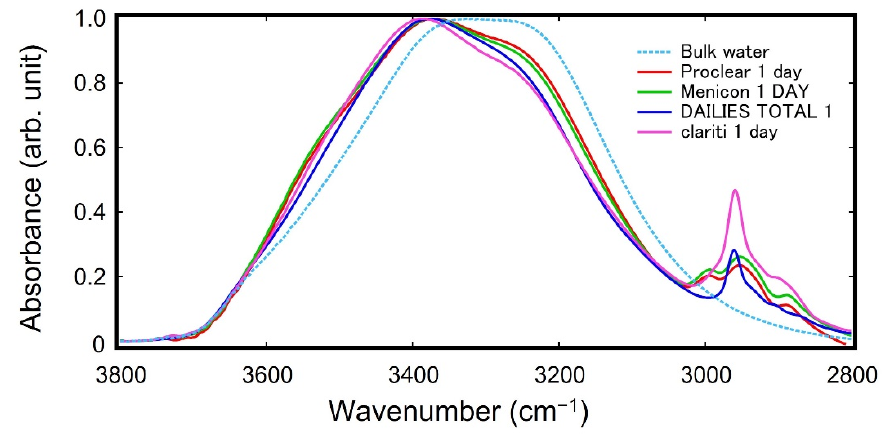
Figure 6. ATR-IR spectra of vicinal water of SCLs in the OH stretching region obtained by the MCR- ALS method. Proclear 1 day and Menicon 1 DAY are PHEMA-based SCLs, and DAILIES TOTAL 1 and clariti 1 day are silicone-based SCLs.